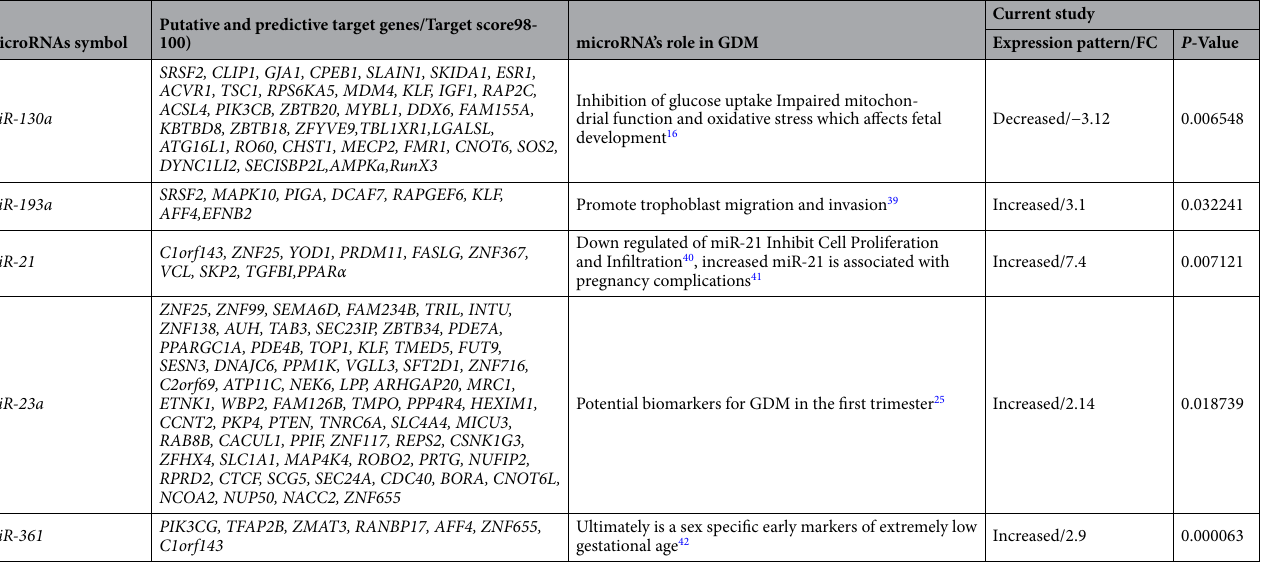
Table 3. MiRNAs role and their putative and predictive target genes in the first trimester of